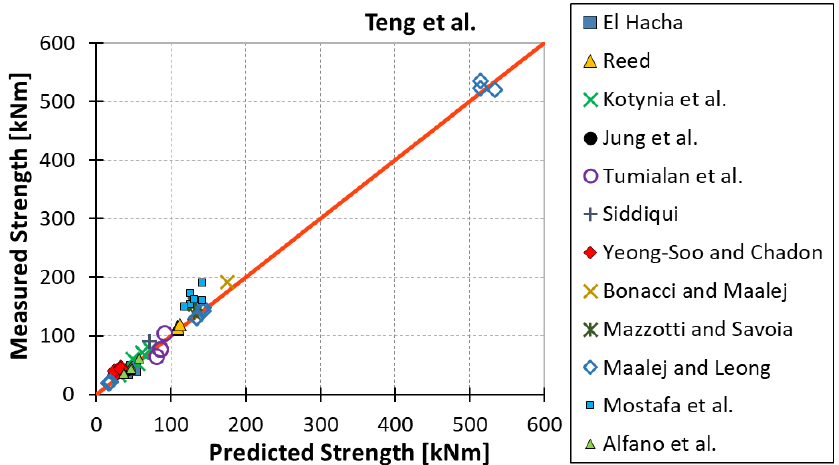
Figure 5. Measured flexural strength versus Teng et al. model prediction.